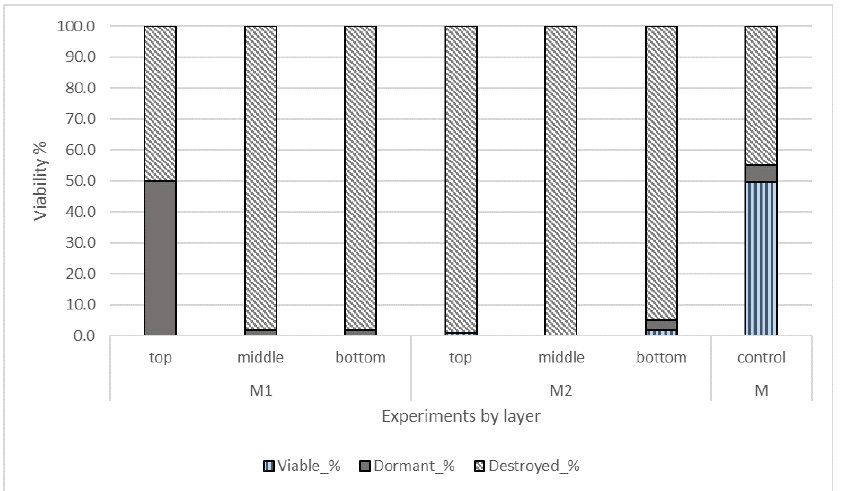
Figure 7. Proportion of viable, dormant and destroyed L. polyphyllus Lindl. seeds after 155 days (M1) or 132 days (M2) in farm-scale mesophilic AD process. M refers to control sample in 155 day process without contact to biomass.